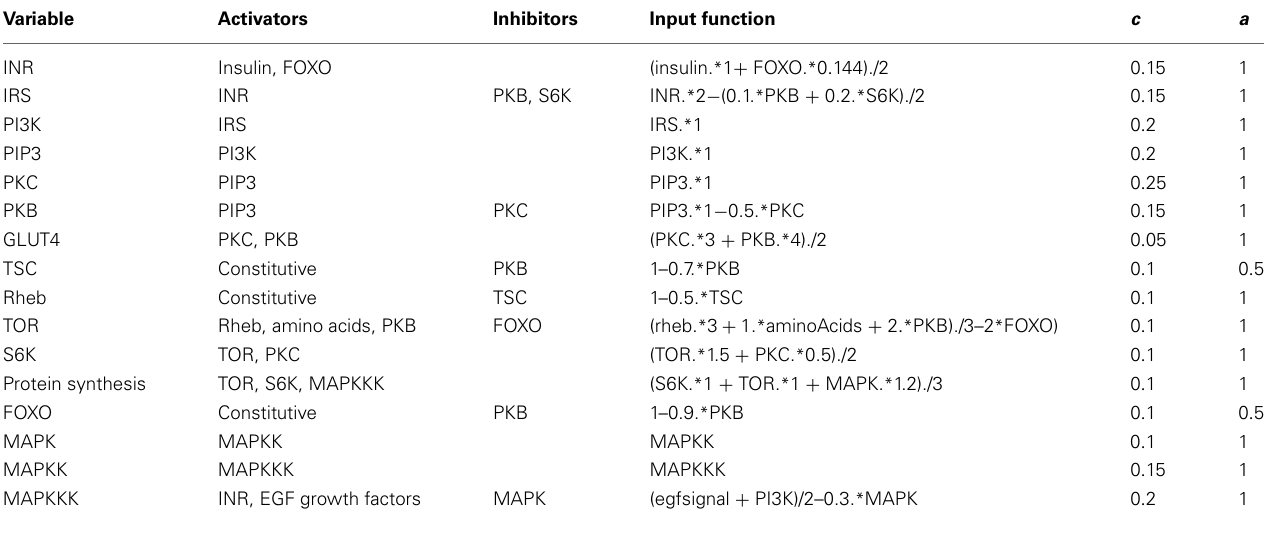
Table 1 | Parameter values and input functions used in the